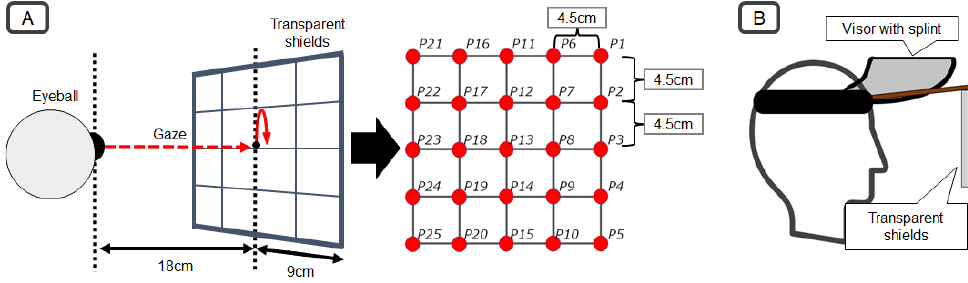
Figure 5. ( A ) Distance interval of marks used for the eye movement task, and ( B ) wearing equipment to present marks in eye movement task. Reprinted with permission from Ref. [25]. Copyright 2021